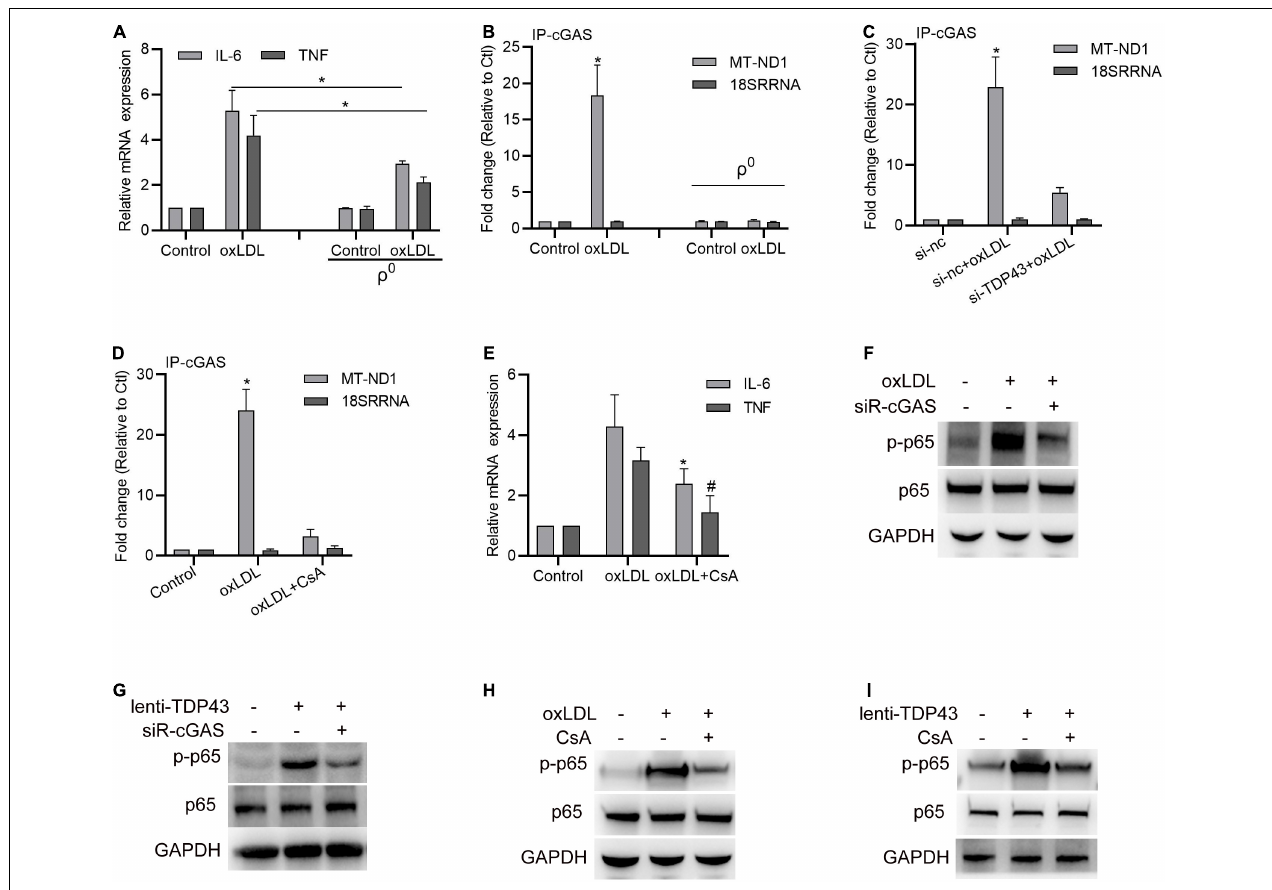
FIGURE 4 | Transactive response DNA-binding protein ∼ 43 kDa (TDP43) mediates oxLDL-induced mtDNA release to activate inflammation. (A) qPCR detection of IL-6 and TNF mRNA in macrophages or mtDNA depleted macrophages ( ρ 0 ) treated with 40 µ g/mL oxLDL or not for 24 h. Data are represented as means ± SD ( n = 3; * P < 0.05). (B) qPCR detection of MT-ND1 (mitochondrial DNA) and 18SSRNA (nuclear DNA) in cGAS immunoprecipitants from macrophages or mtDNA depleted macrophages ( ρ 0 ) treated with 40 µ g/mL oxLDL or not for 24 h. Data are represented as means ± SD ( n = 3; * P < 0.05 vs. control group). (C)